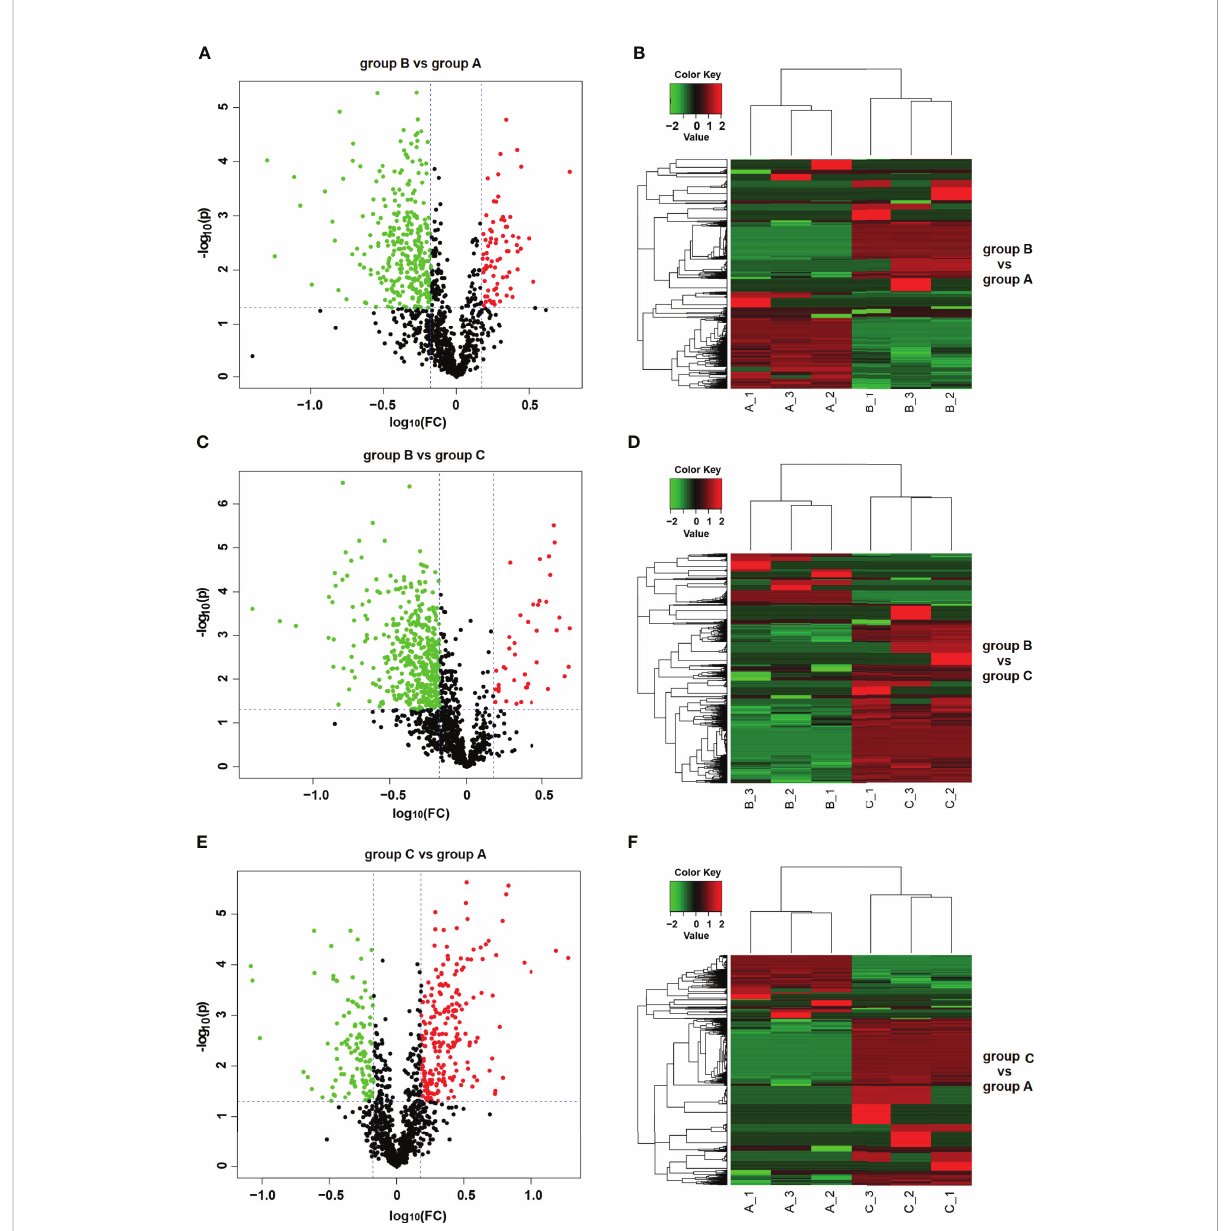
FIGURE 3 Differentially expressed proteins (DEPs) detected between different groups of S. japonica . Volcano plot of group B vs group A (A) , group B vs group C (C) and group C vs group A (E) . The up- and down-regulated proteins are marked in red and green, respectively. Heatmap of group B vs group A (B) , group B vs group C (D) and group C vs group A (F) . Red and green colors represent high and low protein abundance,